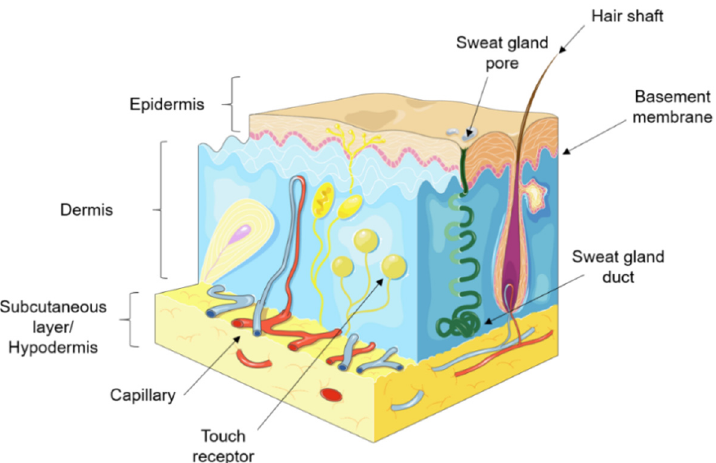
Figure 1. The skin anatomy is composed by three layers: epidermis, dermis and hypodermis. It is a complex organ constituted by different tissues that, when intact, provide protection from the environment. Based on [14] and adapted and modified from Servier Medical Art. Servier is licensed under a Creative Commons Attribution 3.0 Unported License.